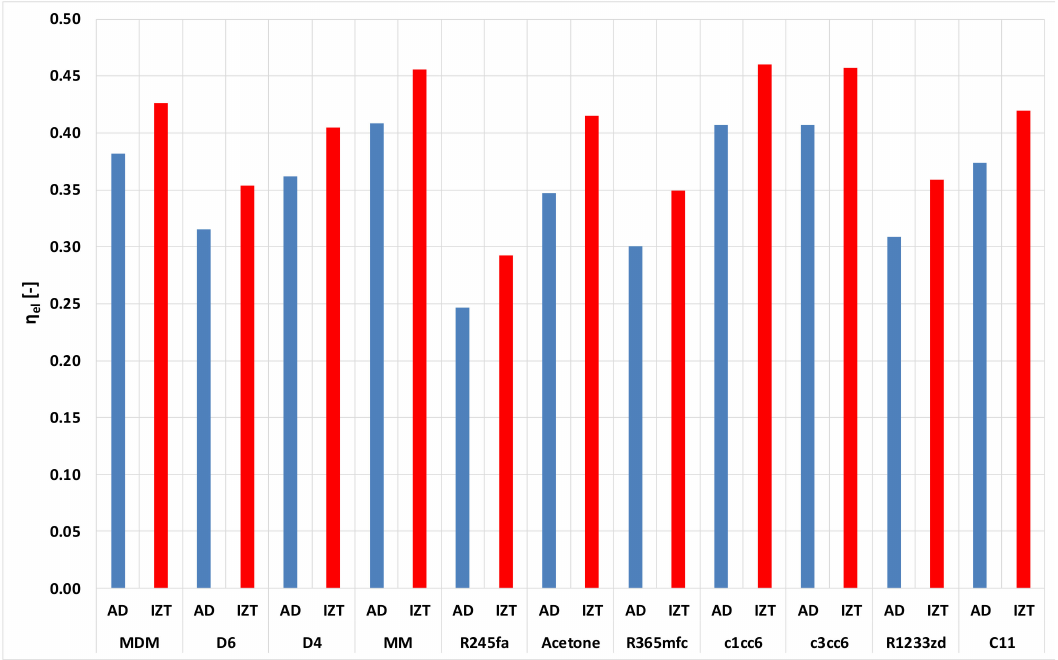
Figure 6. Variant 2—overall e ffi ciency for adiabatic and isothermal expansions (red bars—isothermal expansion, blue bars—adiabatic